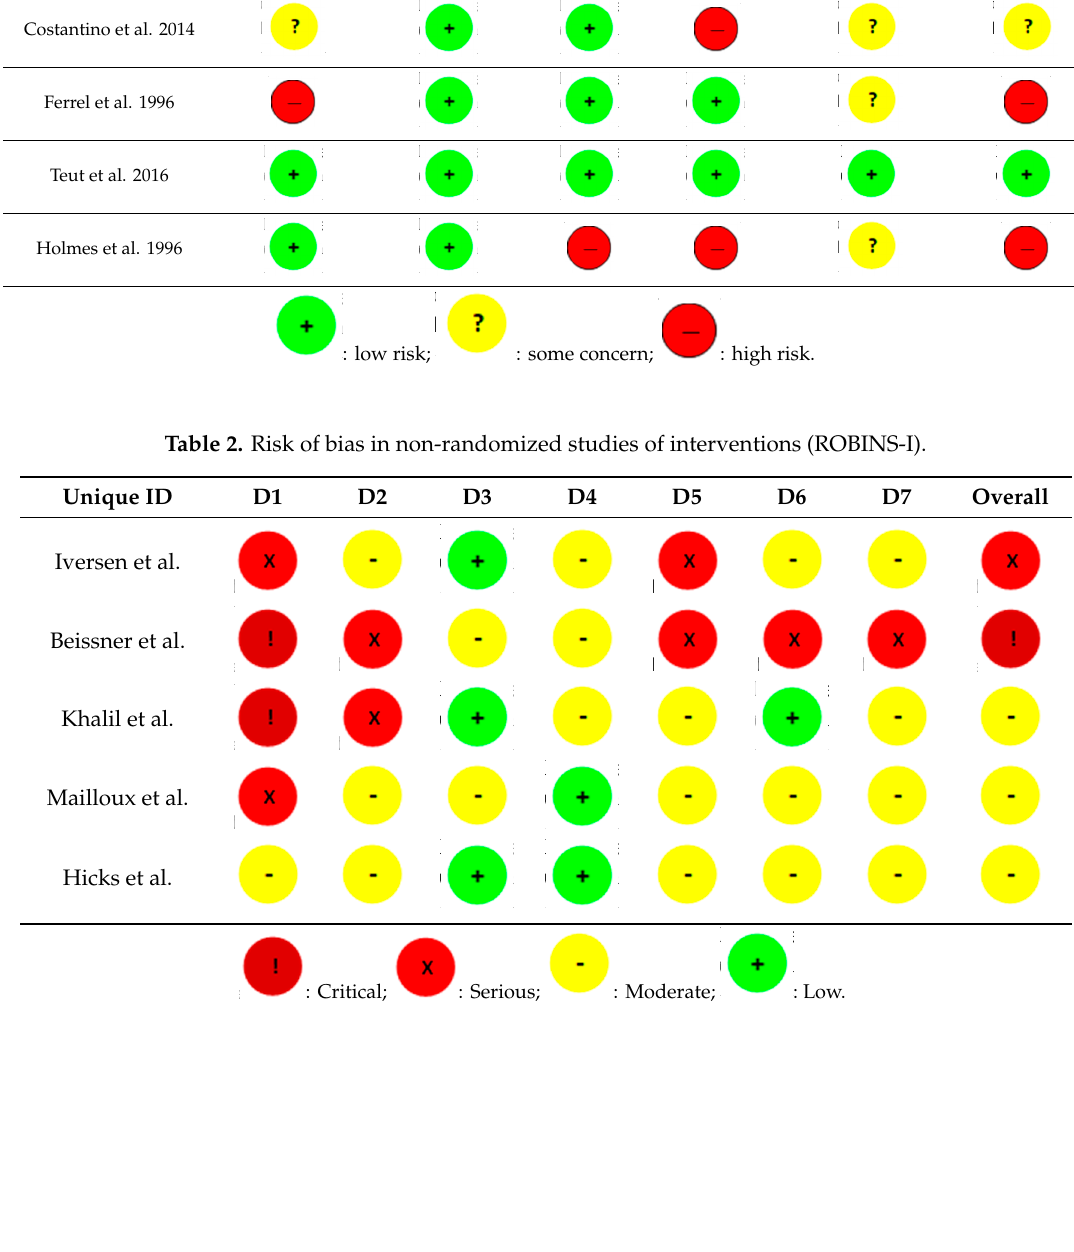
Table 2. Risk of bias in non-randomized studies of interventions (ROBINS-I). Unique ID